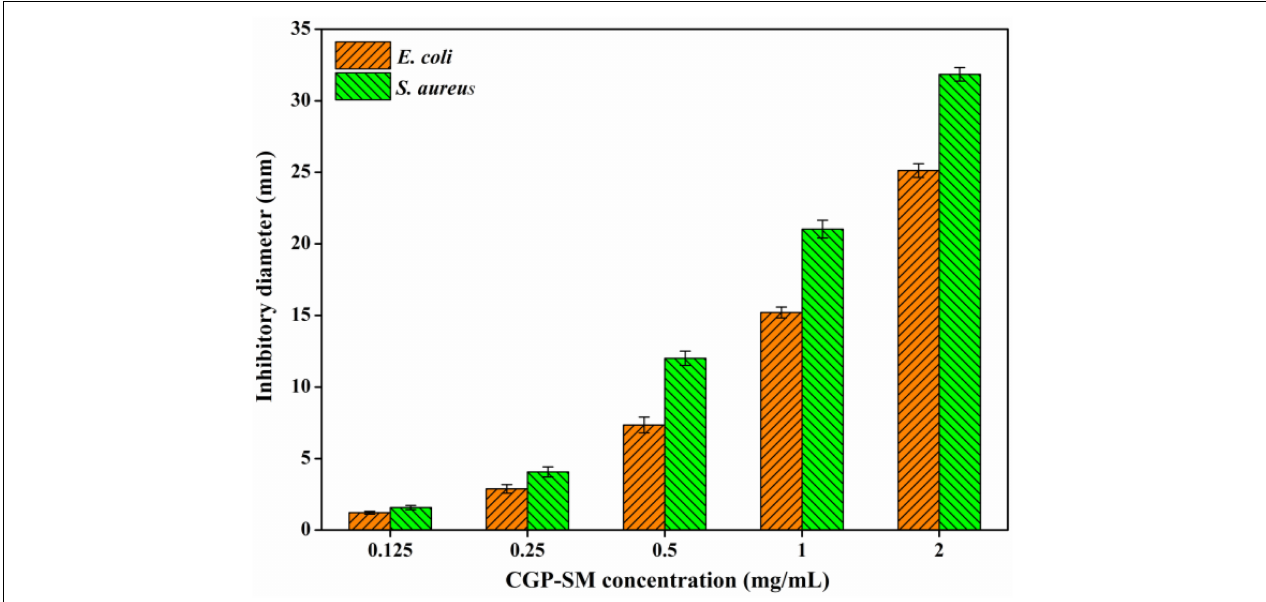
FIGURE 6 | Antibacterial activity of CGP-SM against Escherichia coli and Staphylococcus aureus with different